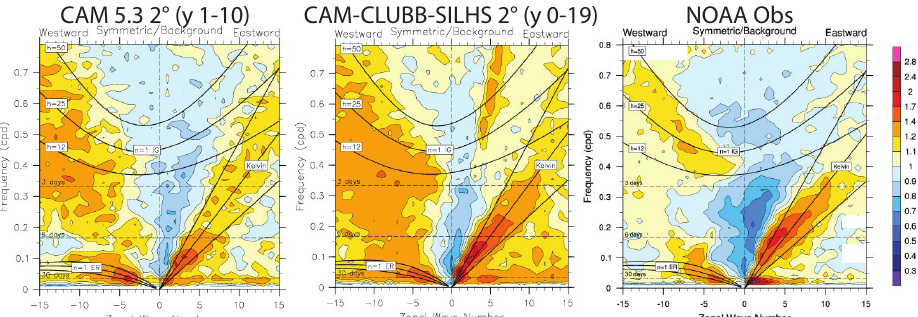
Figure 9. OLR power divided by the background spectra for various wavenumbers and frequencies in the tropics for CAM 5.3 (left), CAM- CLUBB–SILHS (center), and NOAA OLR observations (right). CAM-CLUBB–SILHS has stronger MJO signal, and a stronger signal for Kelvin waves, than CAM 5.3